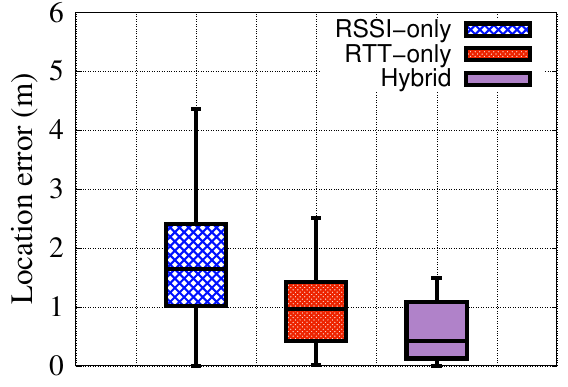
Figure 11. Effect of varying the considered modality on RRLoc